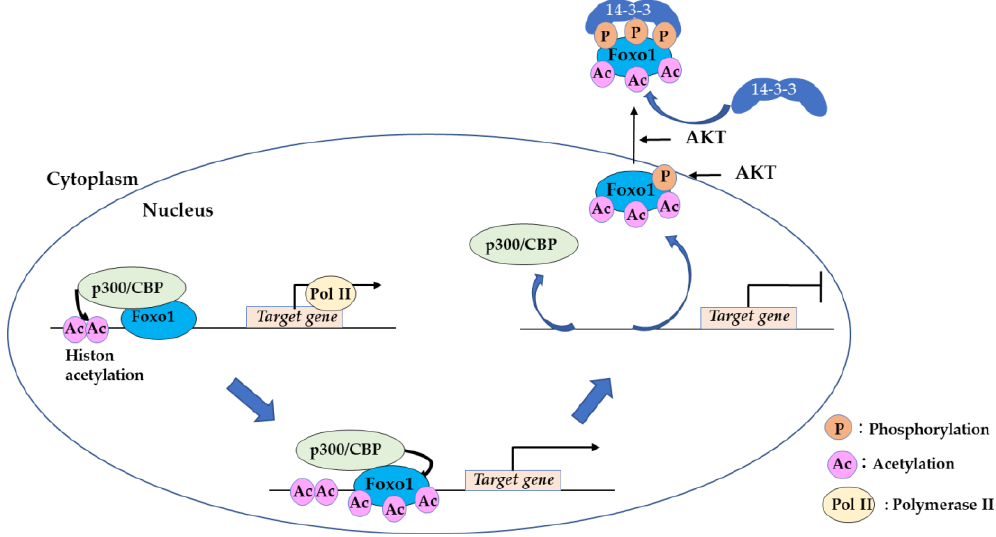
Figure 2. Transcriptional activity regulated by p300 / CBP. The p300 / CBP–Foxo1 complex activates target genetranscriptionbyhistoneacetylation. Foxo1isthenacetylatedbyp300 /